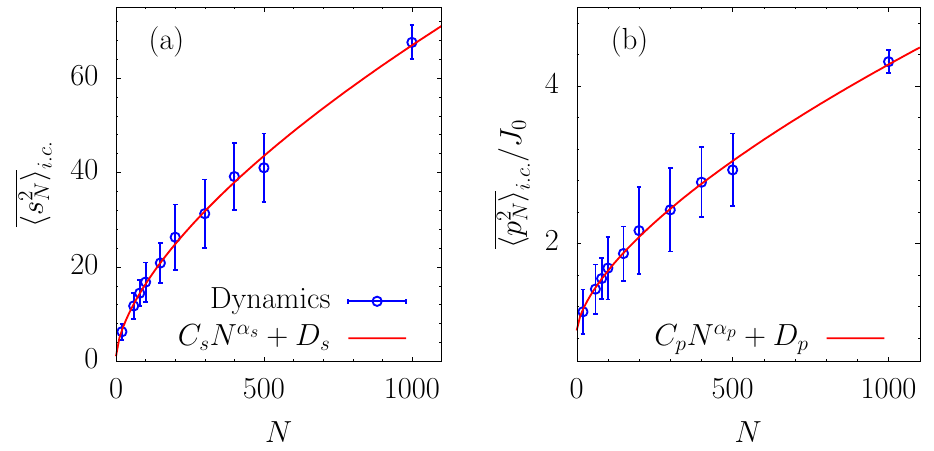
Figure 16: Scaling of the averages at the edge of the spectrum for a phase IV = 0.8 J point , T and J = 0.6 J 0 0 α = p